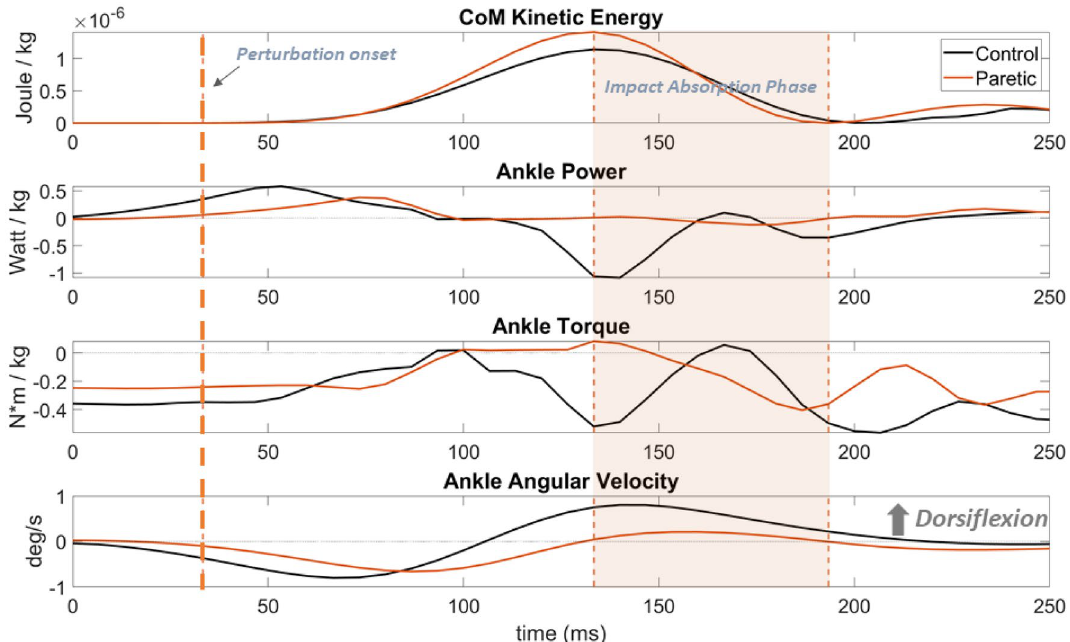
Figure 2. A representative trial showing CoM kinetic energy and ankle joint power, torque and angular velocity from a control participant and the paretic side of a participant post-stroke. Highlighted area represents the impact absorption phase for the paretic limb.